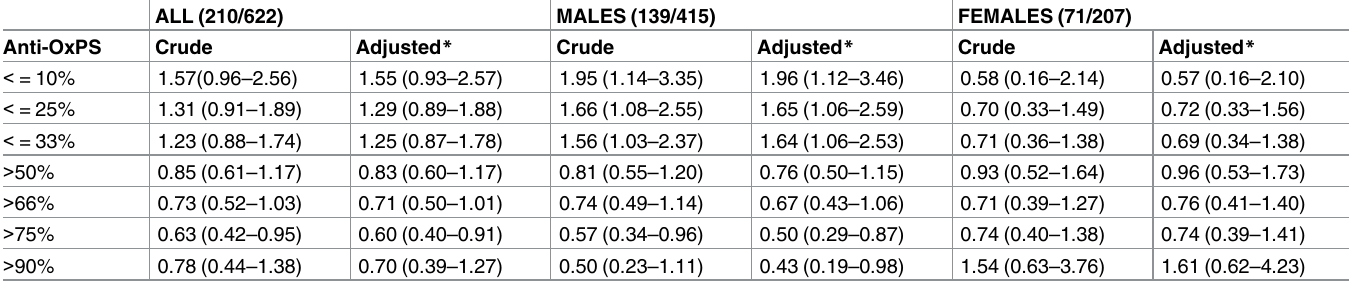
Table 5. Association between levels of IgM anti-OxPS and risk for MI and/or + stroke (CVD), among all participants and men and women sepa- rately. Both cases and controls were includedas the basis for divisioninto seven percentileswhere the one studiedis comparedto the rest. ALL